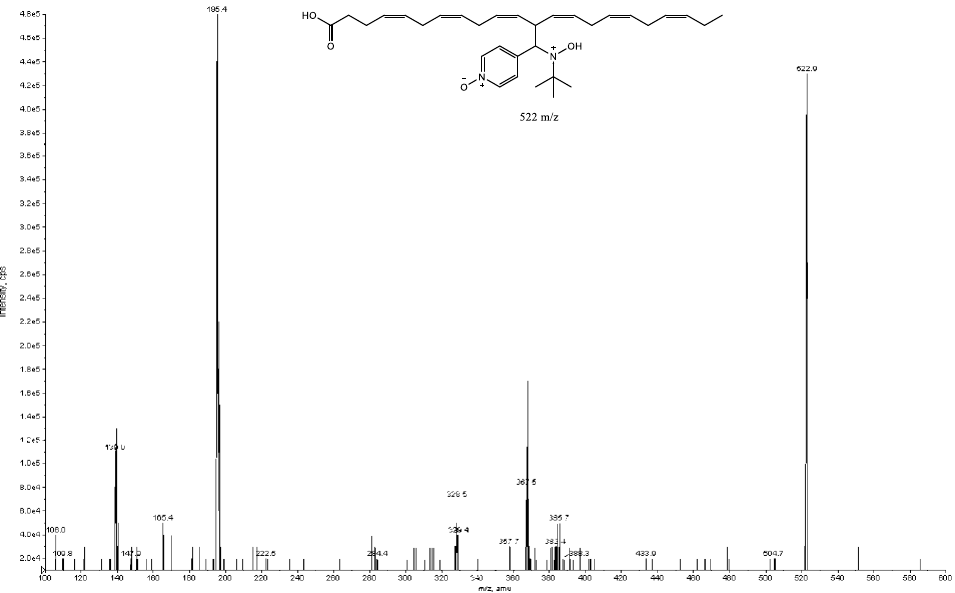
Figure 2. ESI MS/MS spectra and structure of DHA-POBN adduct.